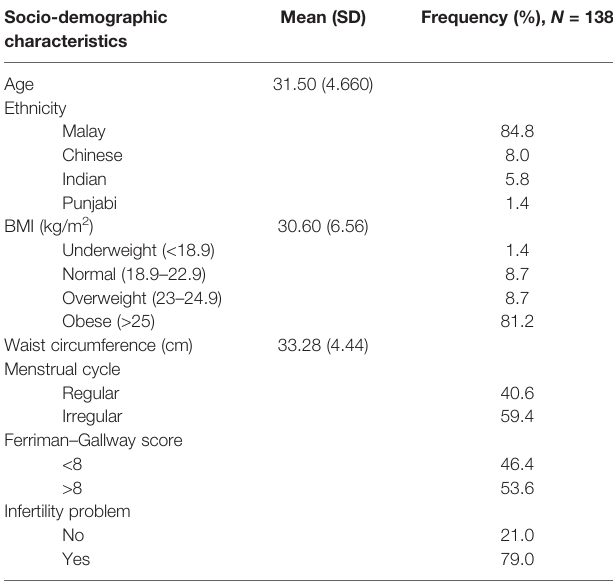
TABLE 1 | Socio-demographic characteristics.